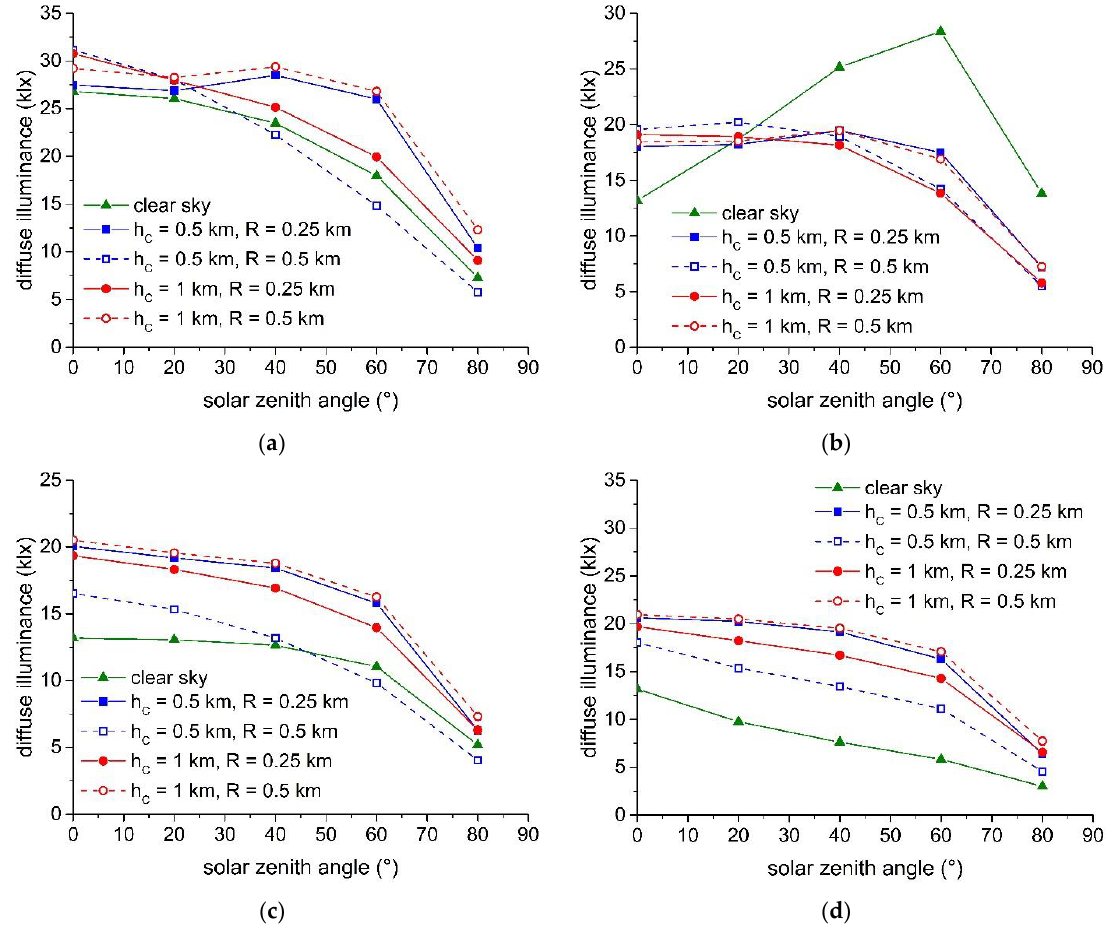
Figure 1. Diffuse illuminance on the horizontal plane ( a ) and vertical planes oriented to the south ( b ), east ( c ), and north ( d ) as a function of the solar zenith angle for a different cloud base altitude h C and radius R . The same distribution of clouds at the cloud fraction of 0.3 was used and also the clear sky for